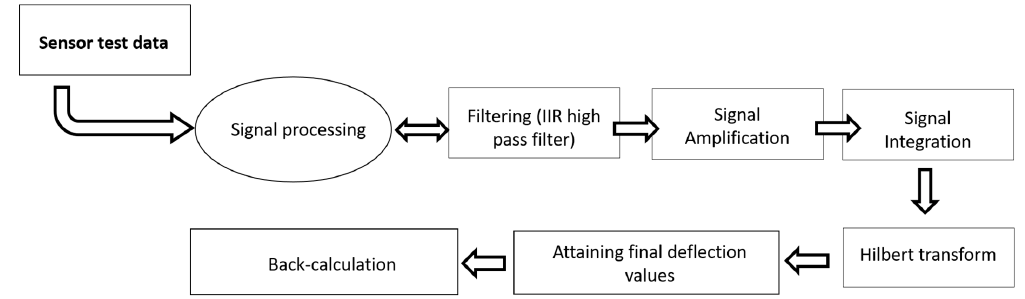
Figure 4. Data conversion scheme.